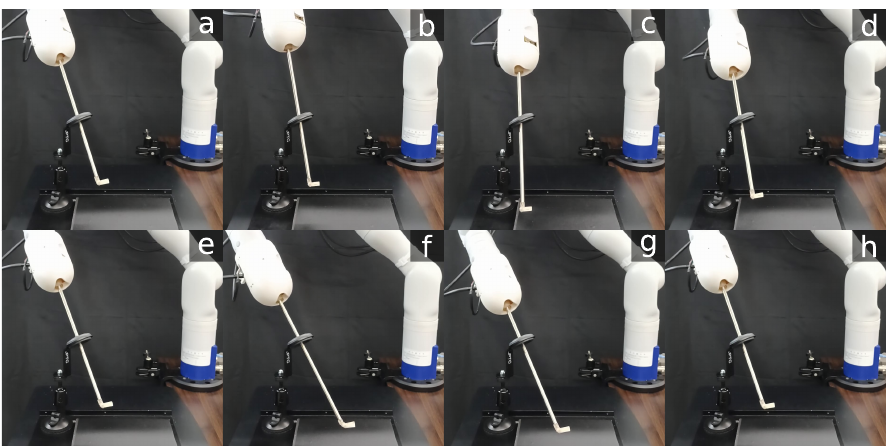
Figure 15. Snapshots of the robotic surgical tool tracking a 6-DOF Lissajous path subjected to an RCM constraint. The labels ( a – h ) indicate the sequence of the robot’s movement along the